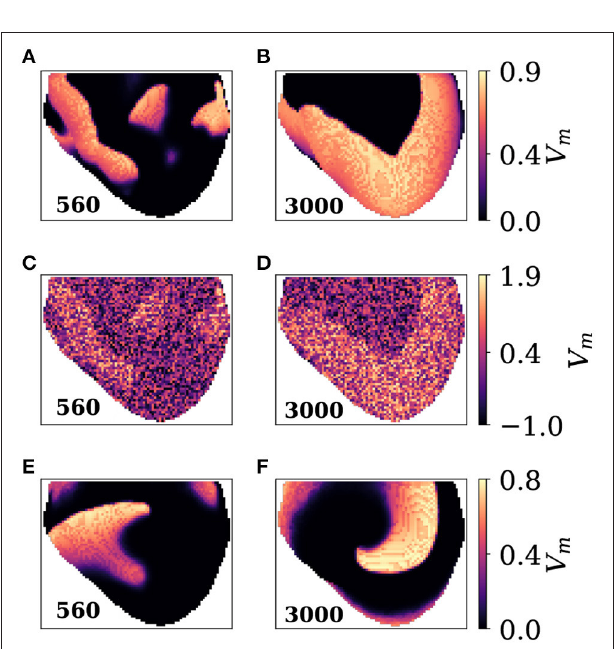
FIGURE 5 | Snapshots of the 3D simulation. (A) Camera 1 at frame 560 showing complex wave activity. (B) Camera 1 at frame 3000 showing plane waves. (C,D) Same as A,B , but with noise added at noise level two. (E,F) Frames 560 and 3000 seen by camera 2. Camera 2 is facing a spiral wave at frame 3000 which causes plane wave activity seen in B